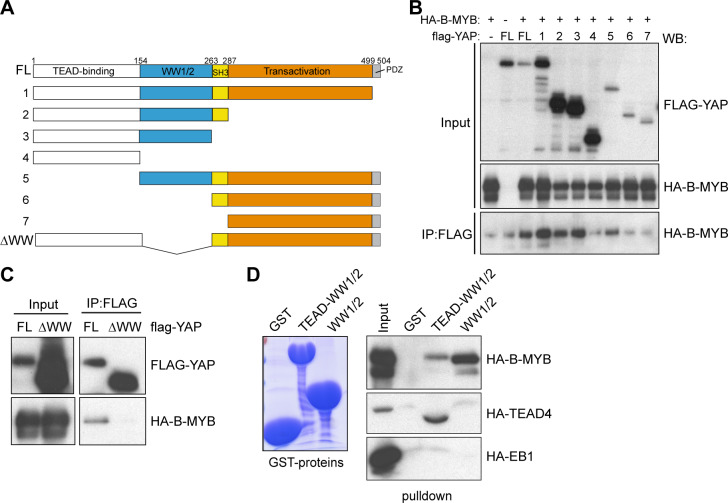
The WW domains of YAP mediate the interaction with B-MYB.A) Scheme of YAP deletion mutants used in co-immunoprecipitation experiments. B) Co-immunoprecipitation of ectopically expressed HA-B-MYB with flag-tagged YAP. Lysates of HeLa cells expressing HA-B-MYB and flag-YAP mutants (see A) were immunoprecipitated with flag-antiserum and immunoblotted with an anti-HA-antibody. 3% percent of total lysate was immunoblotted (Input). Background bands of faster mobility than the full-size proteins are most likely degradation products. A quantification of the experiment is provided in S5A Fig. C) Co-immunoprecipitation between flag-YAP and HA-B-MYB demonstrating that the WW domains of YAP are required for the interaction with B-MYB. D) Pulldown experiments with 5 μg of the indicated recombinant GST-fusion proteins and with HA-B-MYB, HA-TEAD4 and HA-EB1 expressed in HeLa cells. Bound proteins were detected with an anti-HA antibody. HA-TEAD was used as a positive control for the interaction with GST-YAP-TEAD-WW1/2 and HA-EB1 served as a negative control. A coomassie brilliant blue stained gel of the purified proteins is shown to the left.